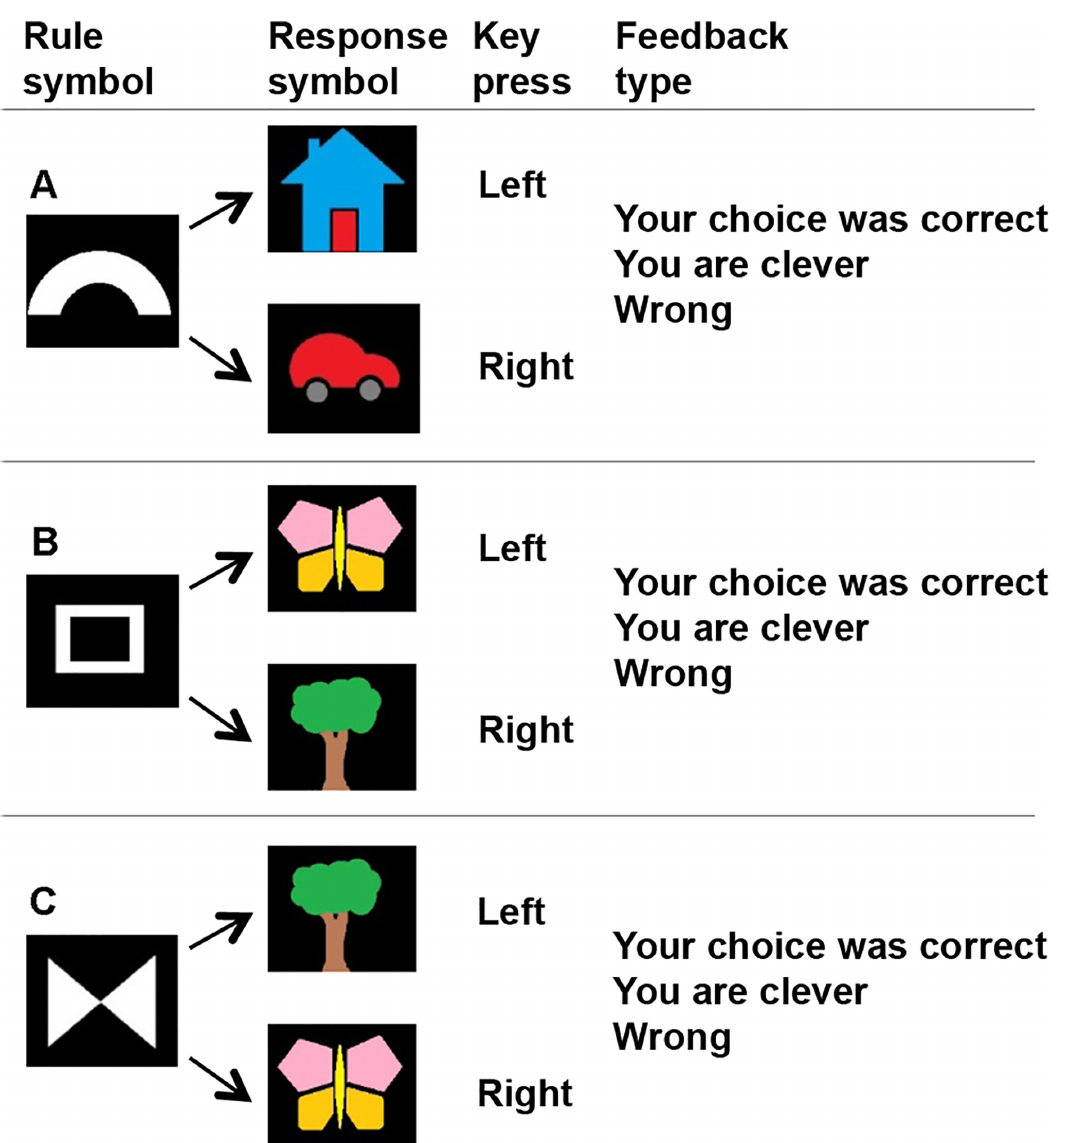
Fig 1. Rule-switching task. A) A univalent rule trial. A rule symbol is presented followed by one of two unique response symbols. B-C) Two bivalent rule trials. Two different rule symbols are used to determine the action to a subsequent response symbol. For example, when seeing the butterfly, either the left or the right key should be pressed depending on preceding rule symbol. A-C) The feedback presented was either task feedback ‘ your choice was correct ’ or trait feedback ‘ you are clever ’ for correct responses, and 'wrong' for incorrect